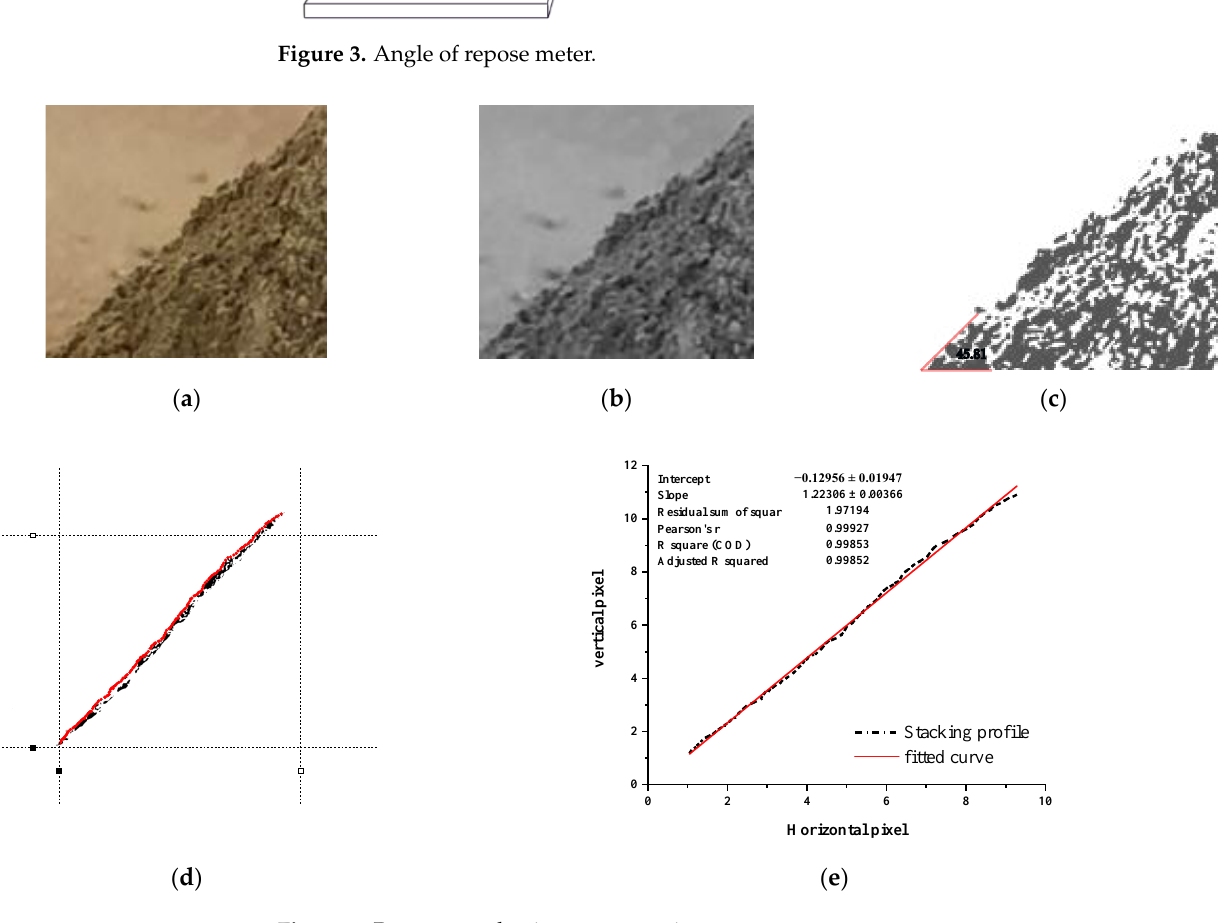
Figure 4. Response value image processing.